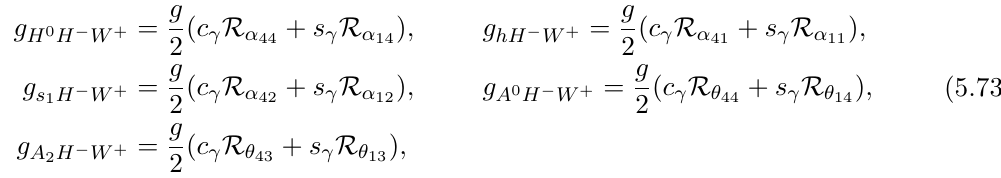
Figure 27 . Variation of R ( D ∗ ) (left) and R ( D ) (right) with R 2 for different values of M N and M The shaded gray region is the experimental 1 σ allowed region while the dotted lines denote the same in the 2 σ CI. The shaded and unshaded colored bands (red,blue,green) signify the theoretical uncertainty in the 1 σ and 2 σ CI